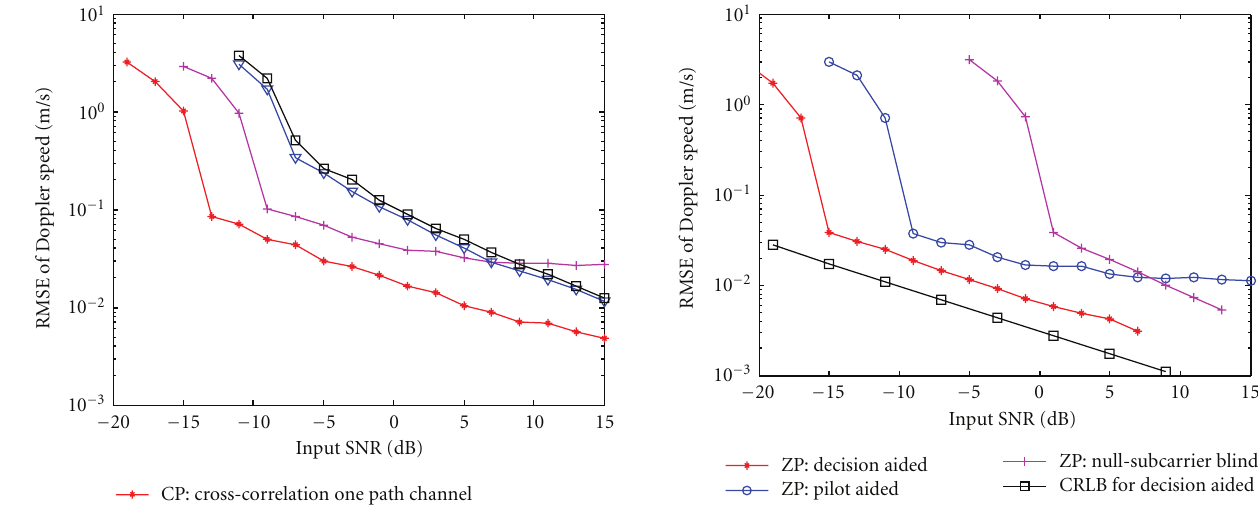
Figure 4: Performance of di ff erent estimators for ZP-OFDM in single-path channels (channel setting 1). The CRLB with all data known is included as a benchmark.